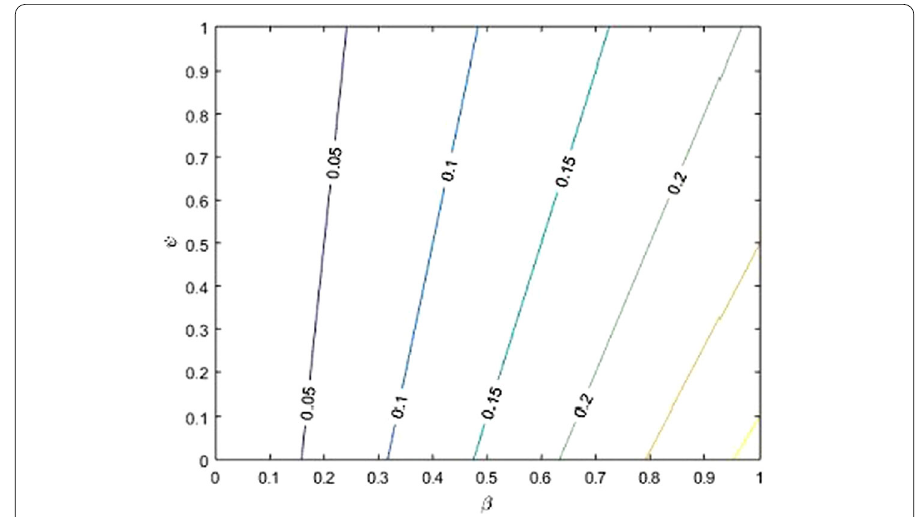
Figure 5 Contour plot of the reproductive number as functions of β and ψ .